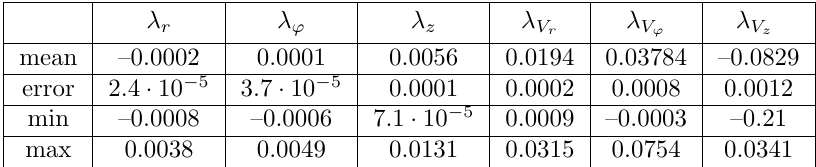
Table 2. The mean Lyapunov exponents for the total sample of open